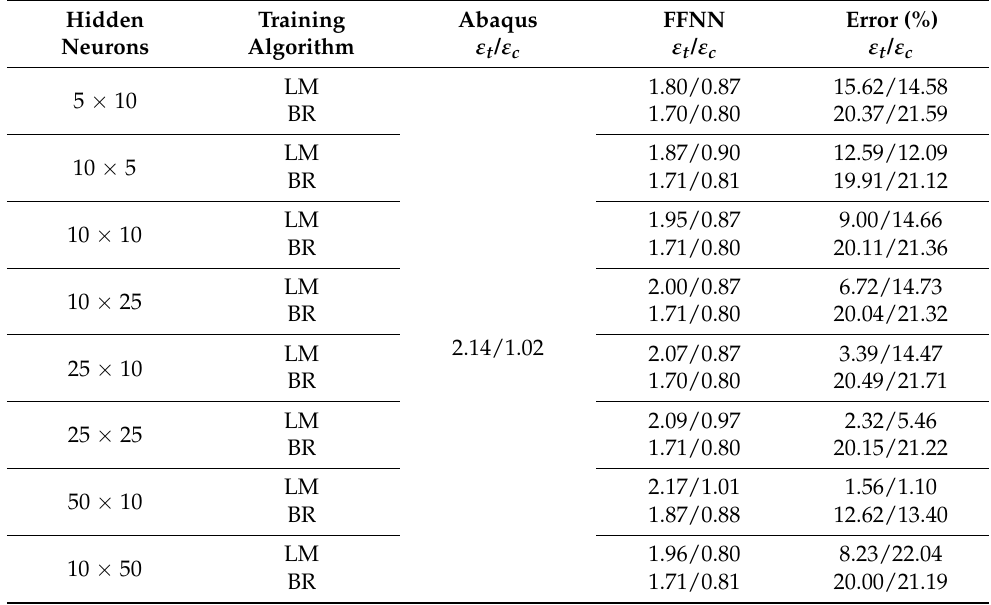
Table 8. Comparison between NN predictions and FEM results of FFNN2 with two hidden layers. Hidden Training Neurons